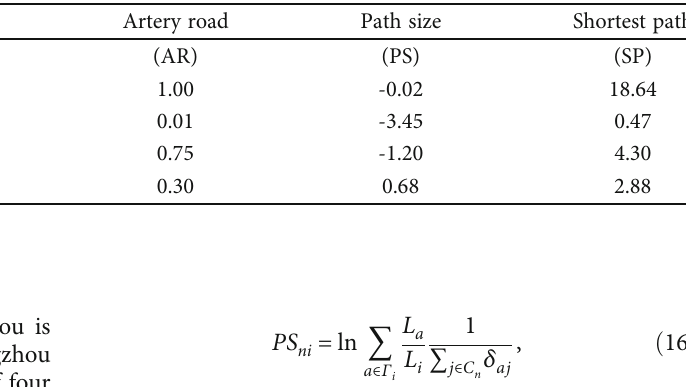
Figure 6: The overall perspective of study area and an example route choice set between an OD pair. Table 1: Statistics on the